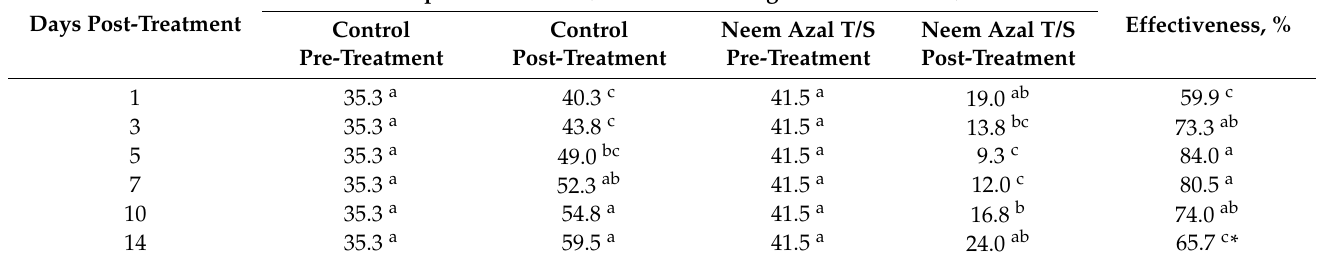
Table 4. Effectiveness of the product Neem Azal T/S 0.3% against two-spotted spider mite ( Tetrany- chus urticae Koch.) in organic bean